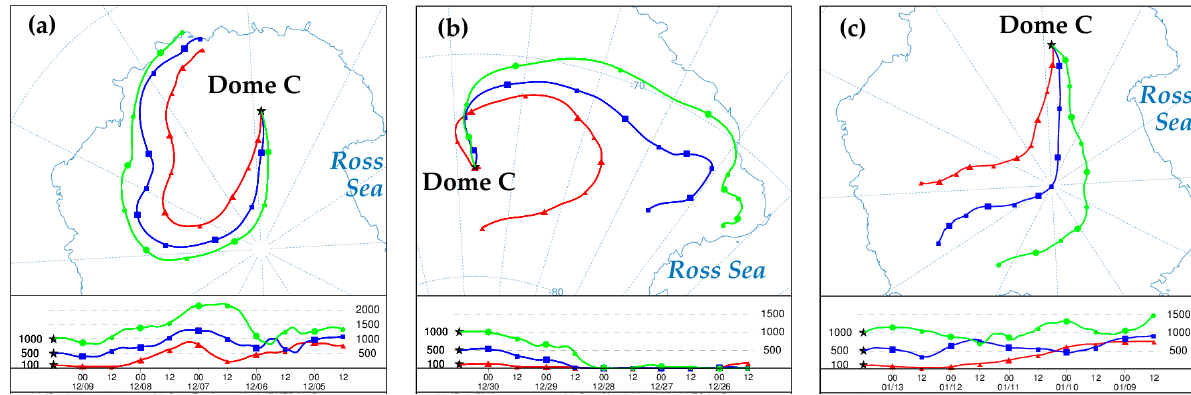
Figure 1. Examples of NOAA Hysplit five-day air backward trajectories run for arrival heights of 100 m (red), 500 m (blue), and 1000 m (green) a.g.l. at 12 am recorded at Dome C during the summer 2005–2006. ( a ) 9 December, 2005; ( b ) 30 December, 2005; ( c ) 13 January, 2006.